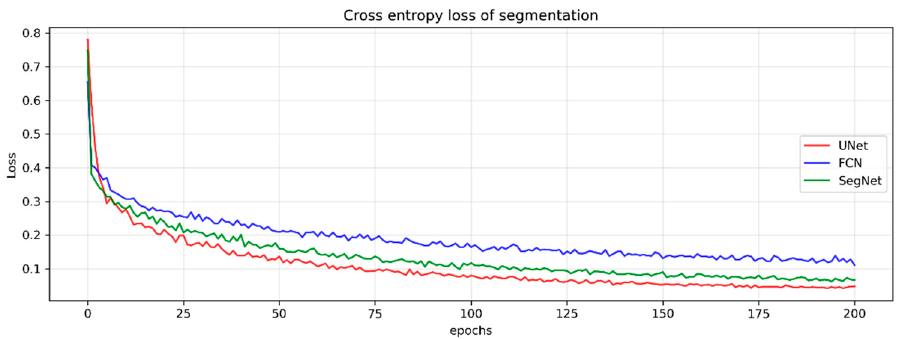
Figure 8. Training process with cross-entropy in U-Net, a fully convolutional network (FCN), and SegNet.